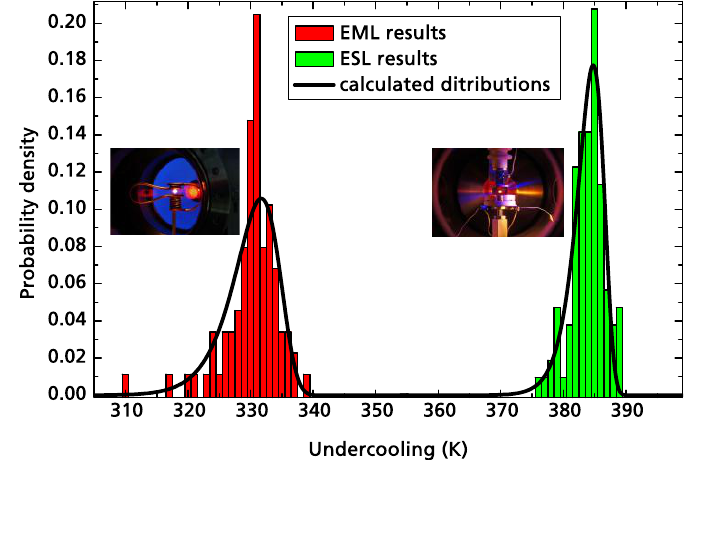
Figure 2. Probability distribution functions of undercoolings measured in approximately 100 cycles on pure Zr in the electromagnetic (red bars) and the electrostatic levitator (green bars) [21]. The solid lines give the functions, as computed according to a statistical analysis of nucleation within the Skripov